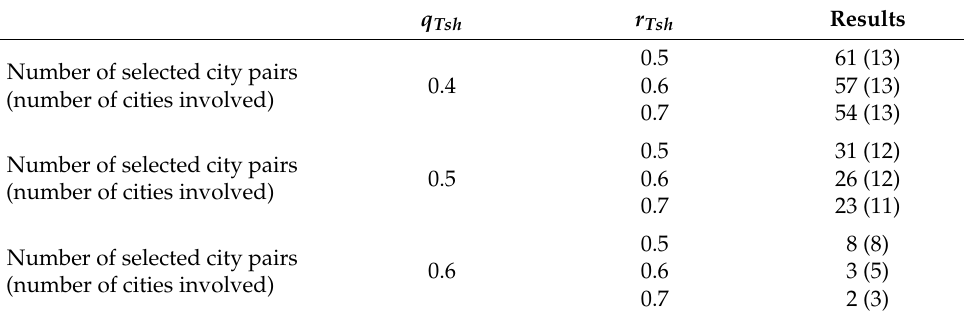
Table 1. Results of selected city pairs for different q Tsh and r Tsh . q Tsh r